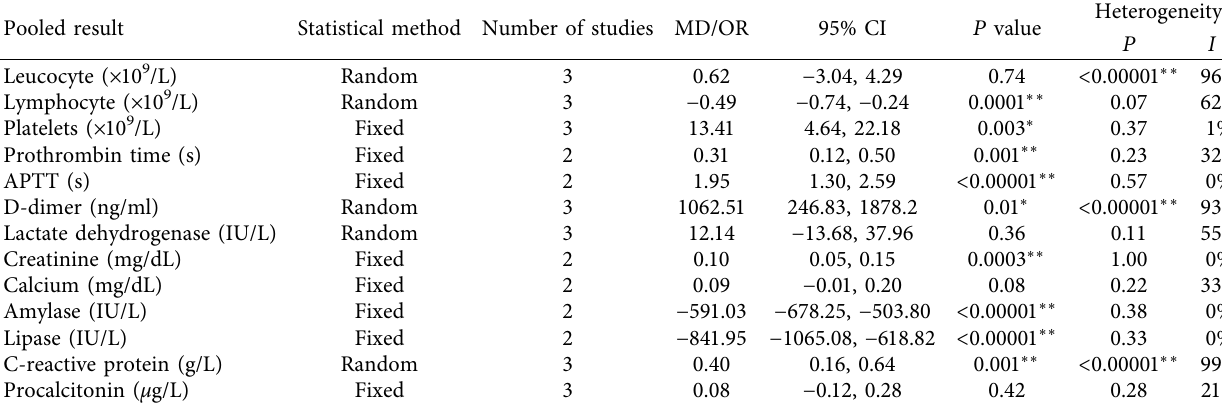
Table 3: Pooled results of laboratory